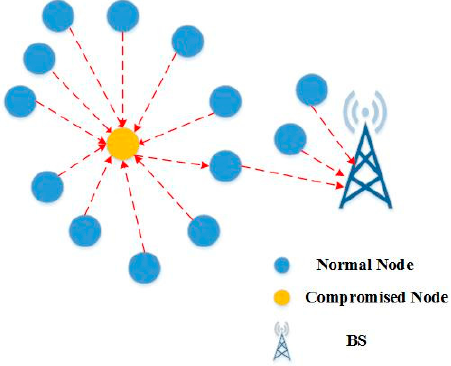
Figure 13. Physical attack on WSN [82].